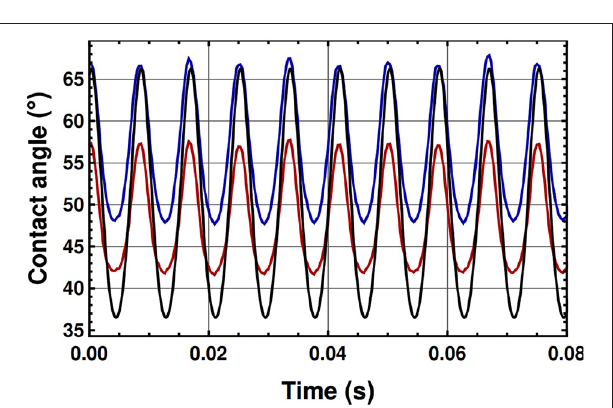
FIGURE 12 | Comparison between predicted and measured contact angles for a slug of PEO1 solution pulsated at frequency of 120 Hz, and a pressure drop amplitude of 225 Pa. Blue and red lines correspond to the contact angle, obtained from experimental measurements, at the left and right walls of the microchannel, respectively; black line corresponds to the theoretical prediction. Agreement between theoretical and experimental results is noticeable, particularly because their oscillation is in